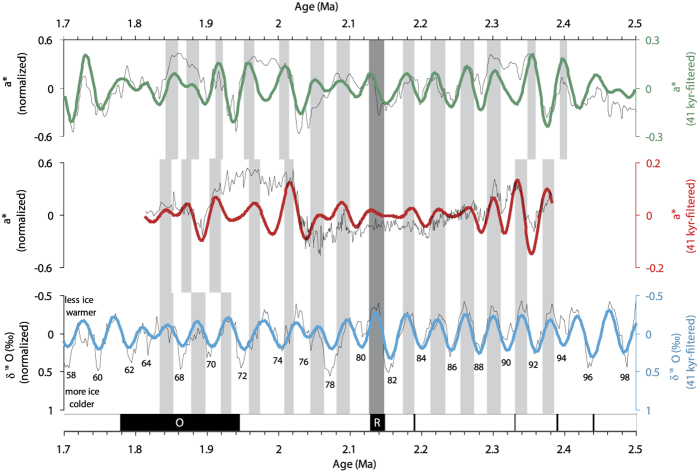
Comparison of redness records from the AB1 section in the NIGP and the Lingtai section31 on the CLP, and the LR04 benthic δ18O stacked curves32.The 41-kyr periodicity band (bold coloured lines) was extracted using the computer program developed by Paillard58; band-pass filters with a central frequency of 0.02439 ka−1 and bandwidth of 0.01 ka−1 were used. All of the records and filtered signals are normalized.